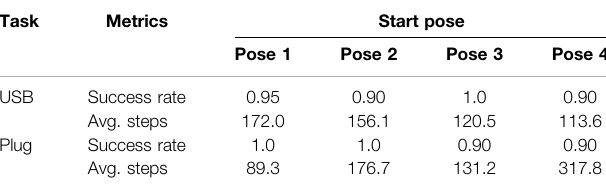
TABLE 1 | Performance on the two real assembly